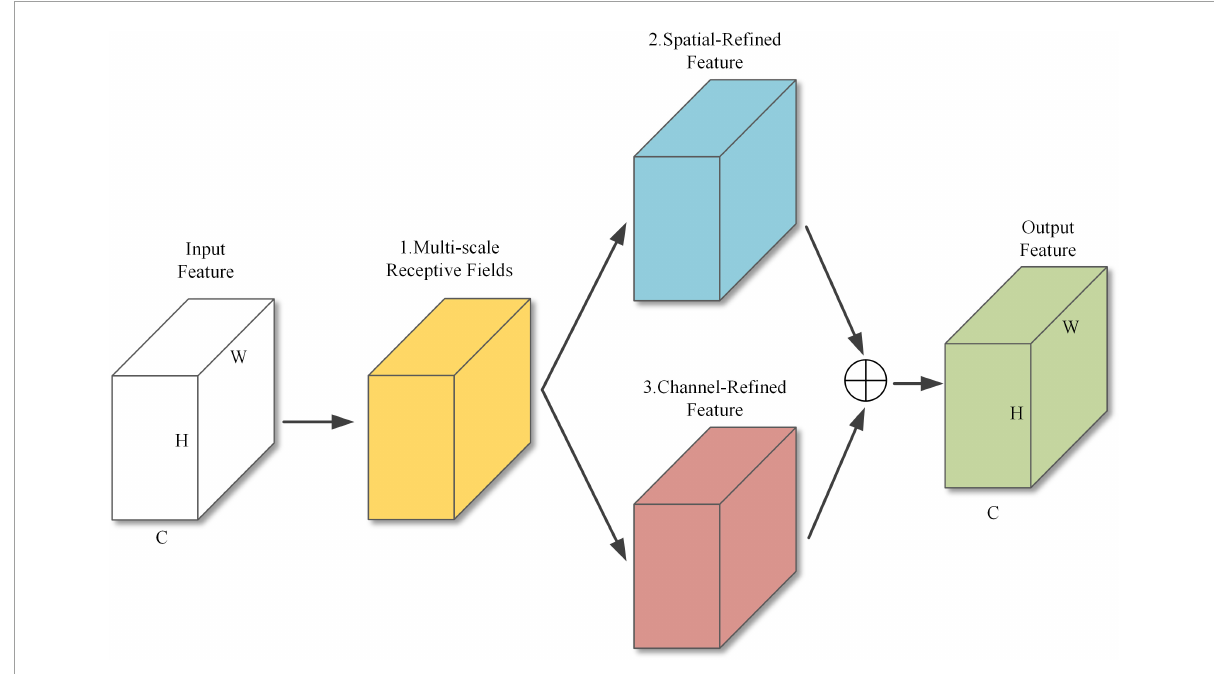
FIGURE5 MFFAM structure.